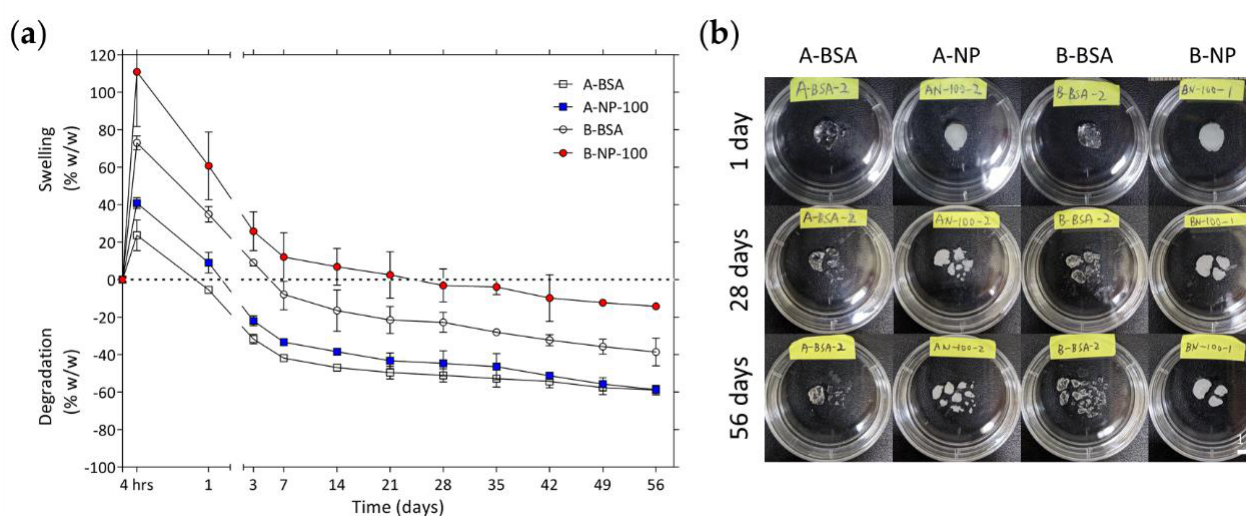
Figure 4. ( a ) Degree of swelling/degradation for various groups loaded with BSA and BSA-laden PLGA NPs. ( b ) Shows enlarged views of each groups after 1 day, 28 days, and 56 days incubation in PBS at 37 °C.